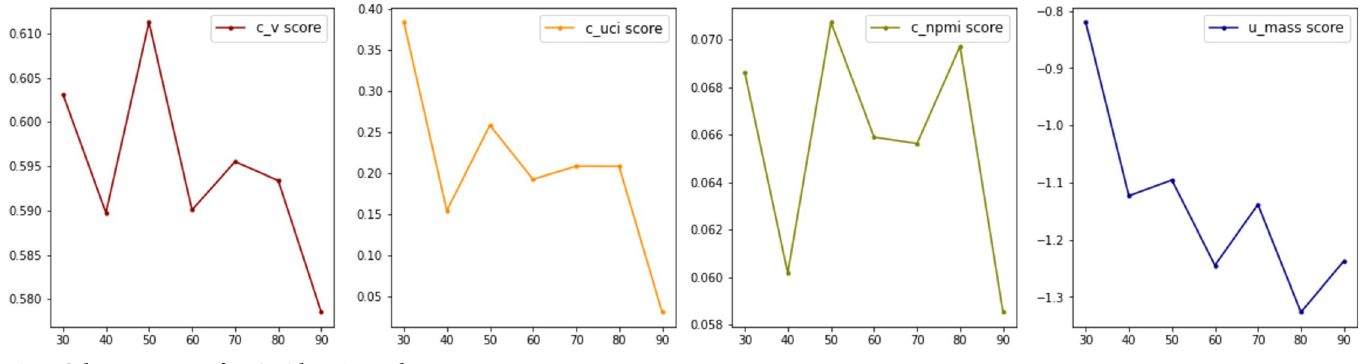
Fig 1. Coherence scores of LDA with topic number 30–100.